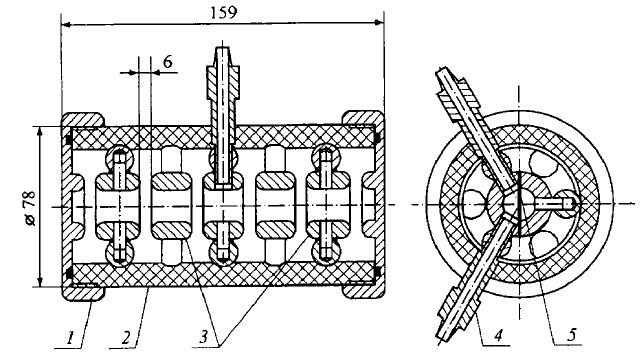
FIG. 4. (Color) Double-ended (left) and single-ended capacitors. The arrow indicates the high-voltage terminal. The other is the